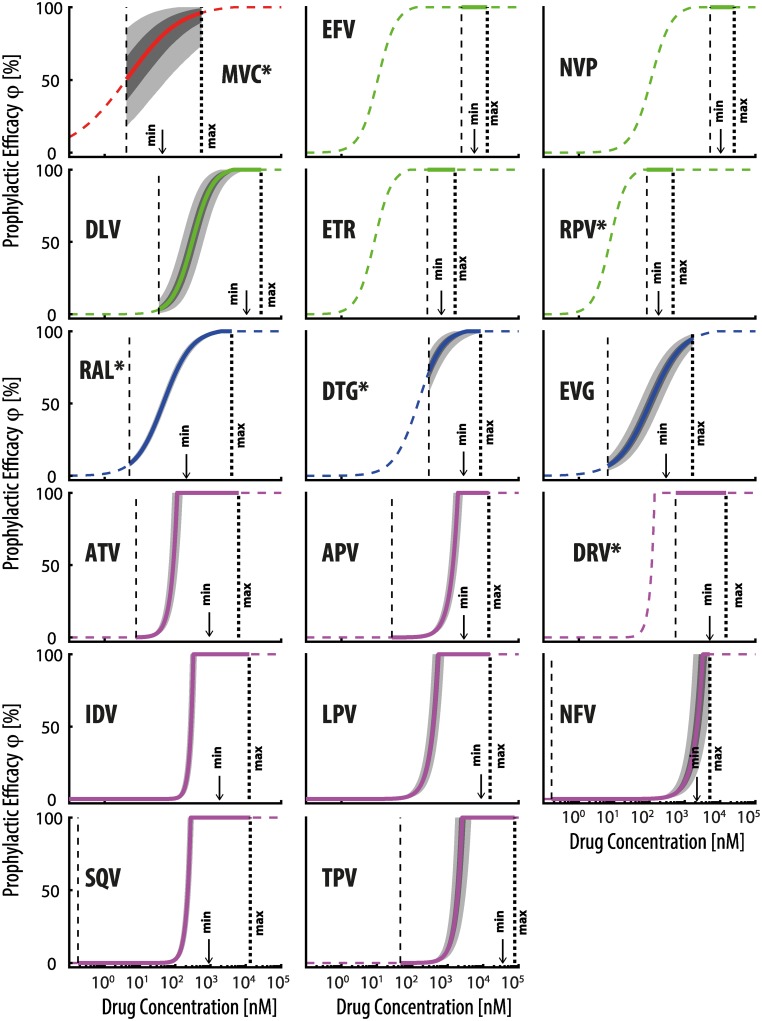
Drug specific prophylactic efficacy.Solid and dashed colored lines depict the concentration-prophylaxis profile for the individual drugs. The solid lines represent the concentration-prophylaxis profiles and light and dark grey areas indicate the quartile ranges and 5-95% ranges of the concentration-prophylaxis profile, considering uncertainty in pharmacodynamic parameters (Table 2) and the distribution of viral inoculum sizes after homosexual exposure to HIV using the virus exposure model’ (Methods section and [18]). Maximum clinically achievable concentrations Cmax for chronic oral administration of the standard dosing regimen and a lower bound concentration Clow that would be achieved if the last dose had been taken three days prior to virus exposure are marked by thick and thin vertical black dashed lines respectively. For IDV, LPV, NFV and SQV Clow falls below the range of the x-axis. Downward pointing arrows indicate minimum (pre-dose) concentrations achieved for standard regimen in adherent individuals as reported in [40], [96] and [95]. MVC -maraviroc, EFV -efavirenz, NVP -nevirapine, DLV -delavirdine, ETR -etravirine, RPV -rilpivirine, RAL -raltegravir, EVG -elvitegravir, DTG -dolutegravir, ATV -atazanavir, APV -amprenavir, DRV -darunavir, IDV -indinavir, LPV -lopinavir, NFV -nelfinavir, SQV -saquinavir, TPV -tipranavir. *recently or currently tested for PrEP.